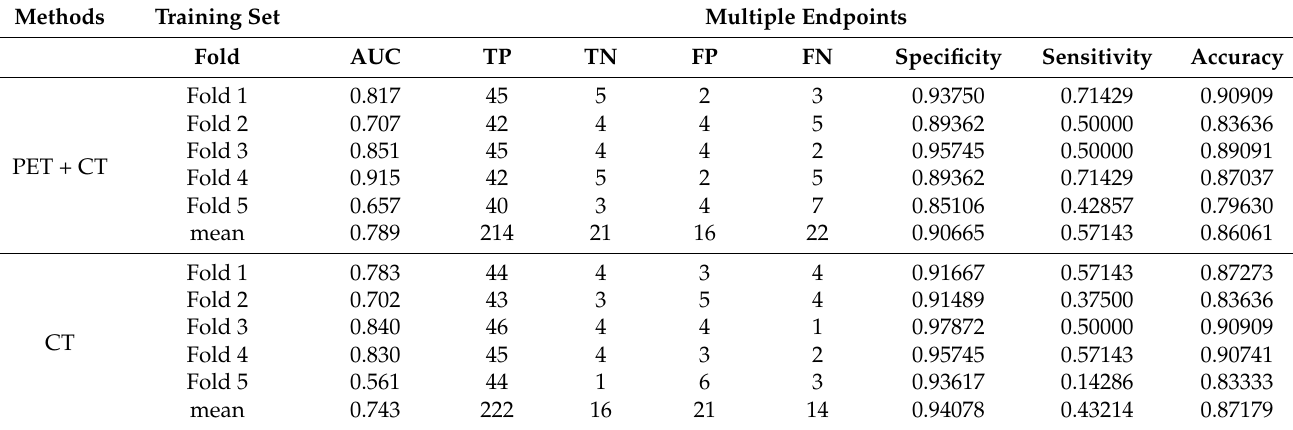
Figure A4. The area under the curve of 0.807 for the PET-CT base. Table A1. Comparison of prediction performances between the proposed